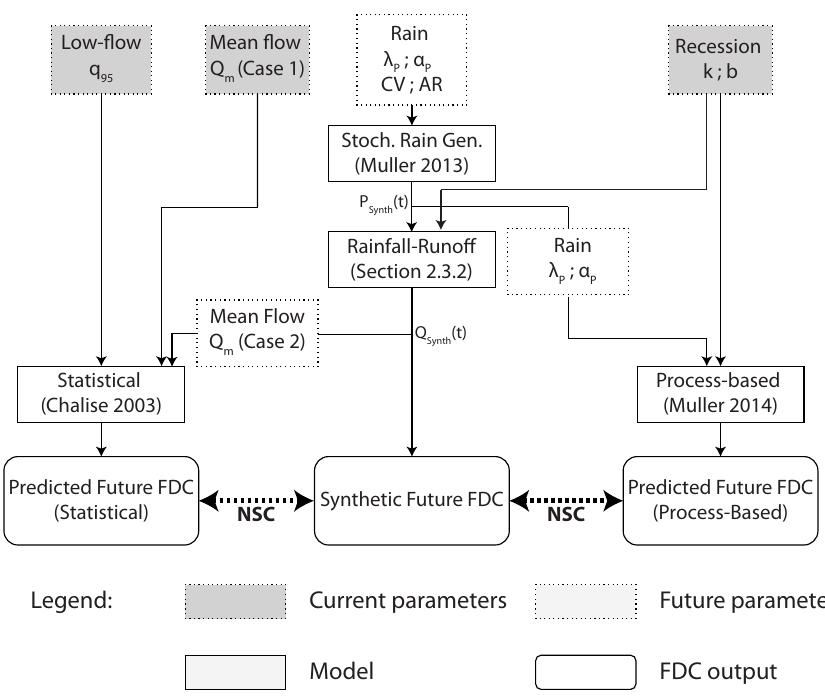
Figure 2. Numerical simulation analysis to assess predictions under change. Future rainfall characteristics (frequency λ P , mean intensity α P , auto-correlation coefficient AR and coefficient of variation CV) are determined according to expected changes in rain regimes in Nepal (see Sect. 2.3.2) and fed into a stochastic rainfall generator. The resulting 1000 years of synthetic daily rainfall values ( P Synth (t) ) are fed into a rainfall–runoff model that simulates the processes described in Sect. 2.1.1. The rainfall–runoff model uses current recession, soil, and evapotranspiration conditions observed at the Chepe Kohla catchment. The resulting 1000 years of synthetic daily flow values ( Q Synth (t) ) are then reordered to construct an empirical synthetic (future) FDC, which was compared (in terms of the Nash–Sutcliffe coefficient) to modeled FDCs predicted by the statistical and process-based models. The process-based model admits current recession conditions but future estimates for rainfall frequency ( λ P ) and mean intensity ( α P ). Note that unlike the numerically generated empirical FDC, the process- based model assumes Poissonian rainfall with exponentially distributed depths, that is, CV = 1 and AR = 0. Current low-flow characteristics ( q 95 ) are fed into the statistical model, as well as the current or future (i.e., computed from synthetic streamflow time series) mean flow, depending on the extent to which mean rainfall is an unbiased predictor of mean flow (Cases 1 and 2 described in Sect.